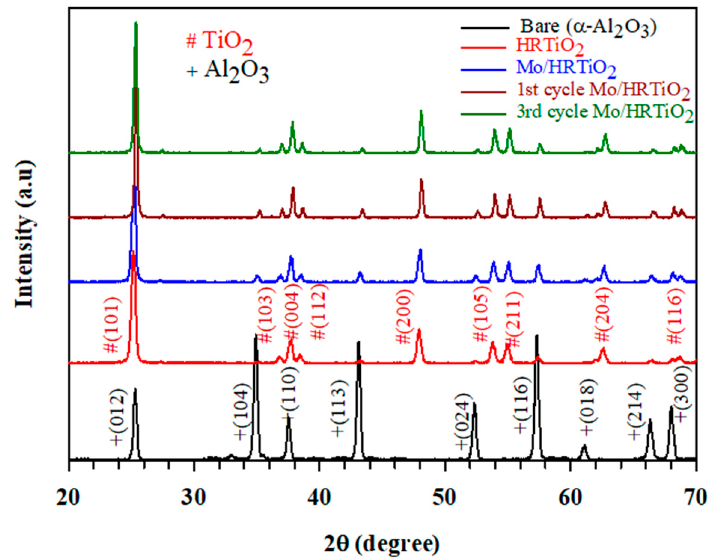
Figure 18. XRD measurement of 1st and 3rd cycle reused supported ~5 mg of Mo/HRTiO 2 on ceramic for IBU degradation in comparison with related control sample materials.